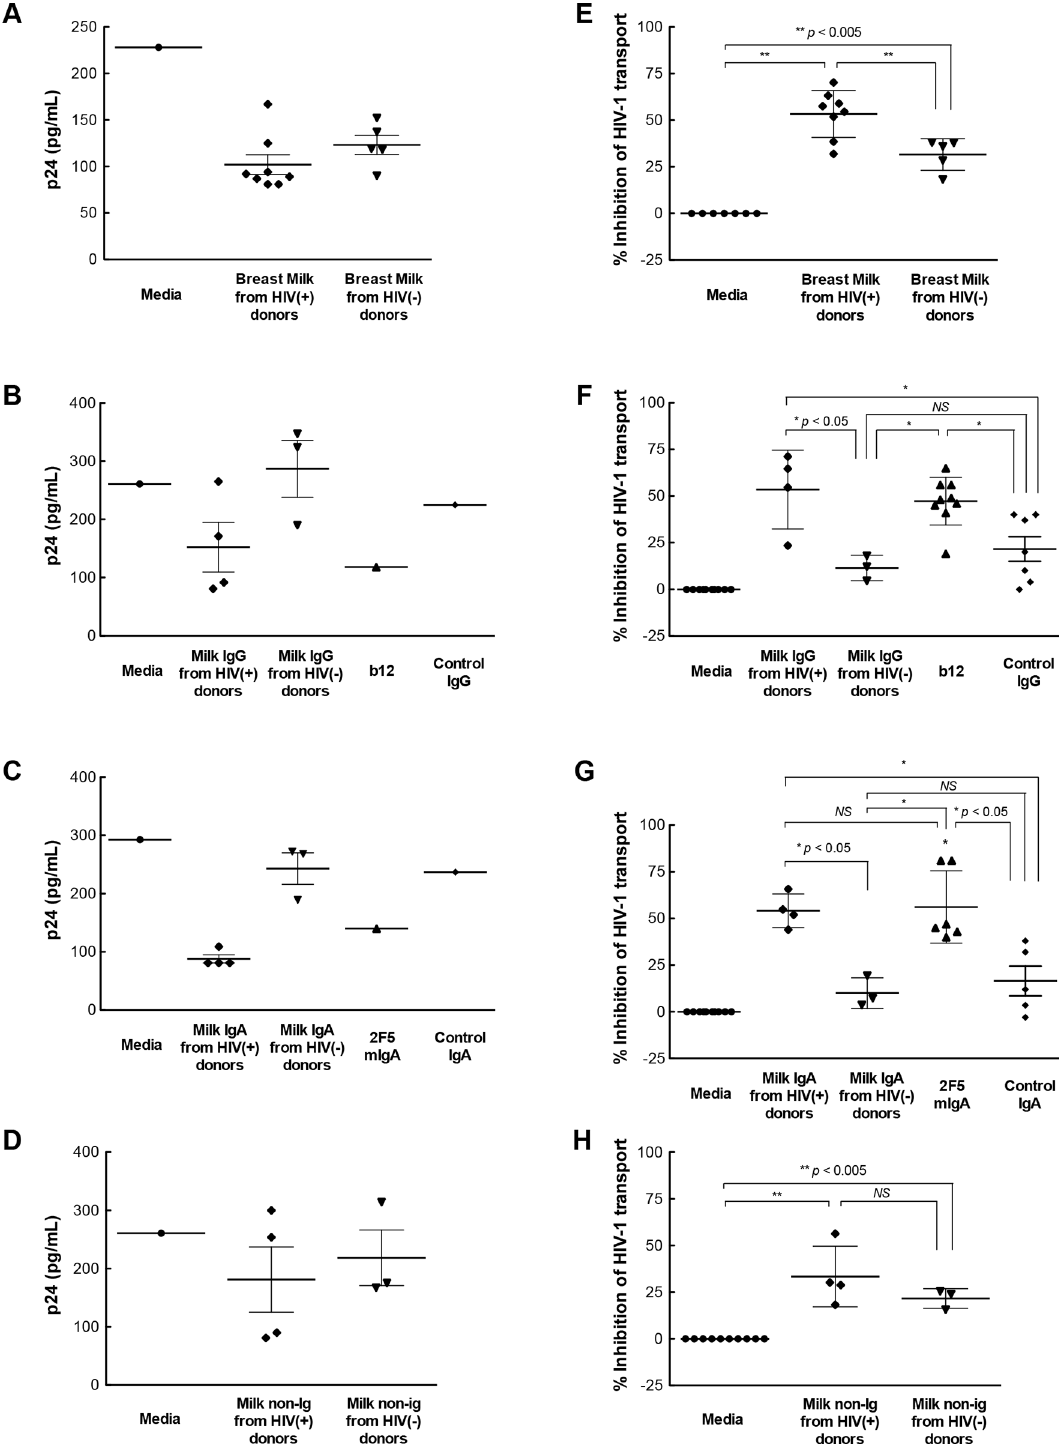
Fig 4. Impact on myeloid DC uptake and transport of HIV-1 through intestinal mucosa. Ugandan subtype A HIV-1 was pre-incubated with (A, E) skimmed breast milk or the corresponding (B, F) IgG, (C, G) IgA or (D, H) non-Ig component (diluted 1:2) for 30 min, applied to the apical surface of explanted intestinal mucosa, and 2 hr later cells in the lower chamber of the explant system were harvested, lysized and measured for HIV-1 by p24 ELISA. Results in panels A-D are p24 values from a representative tissue donor. Values in panels E-H represent the mean percent inhibition of HIV-1 transport by one breast milk through tissue from 3 – 5 separate tissue donors for unfractionated milk ( E ), purified milk IgG ( F ), purified milk IgA ( G ), and Non-Ig fractions ( H ). DC